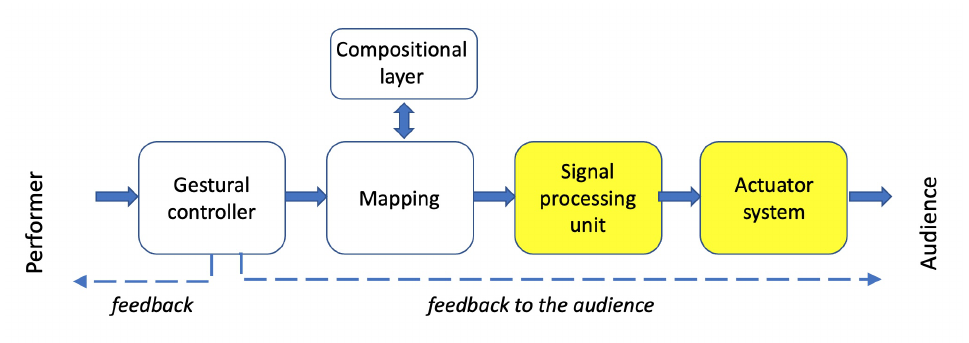
Figure 4. Scheme of a Multimodal Performance System. In yellow the units dealing with multimodal